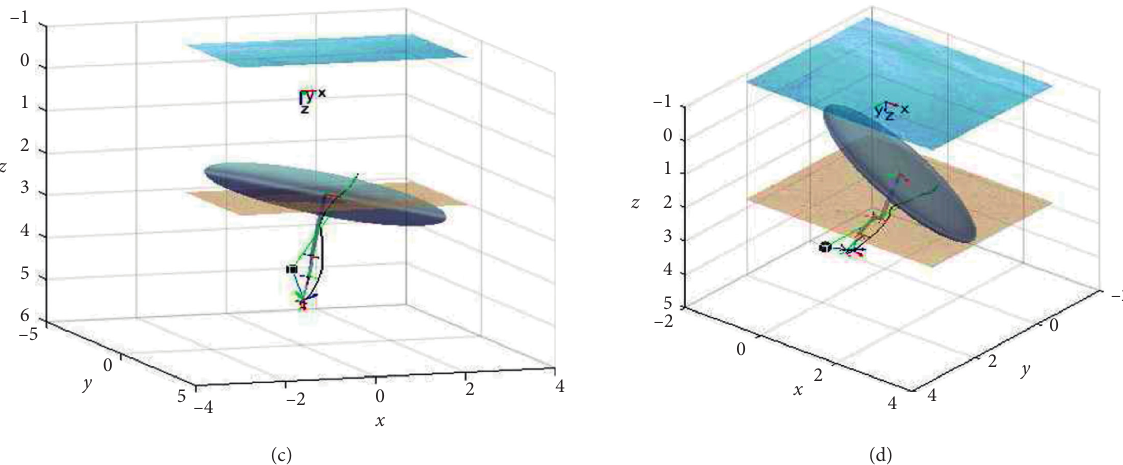
controller based on ∞